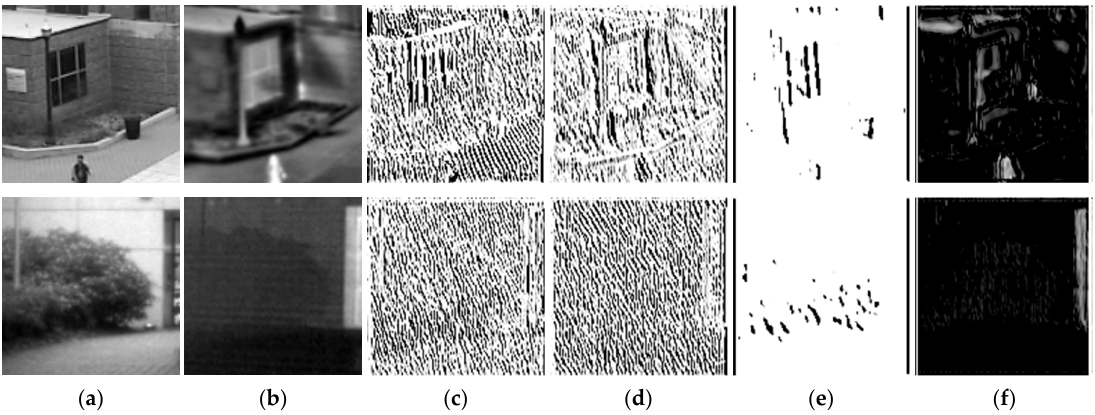
Figure 14. Comparison of fine-feature maps for shallow feature extraction network with and without shared weight. From left to right: ( a ) visible image patch, ( b ) infrared image patch, ( c ) visible fine-feature map in shared weight, ( d ) infrared fine-feature map in shared weight, ( e ) visible fine-feature map in w/o. shared weight (proposed method), and ( f ) infrared fine-feature map w/o. shared weight (proposed method). Table 4. Comparison of corner error [31] for shallow feature extraction network with and without weight sharing. Row 2 and 3 represent the corner error [31] corresponding to the two sets of sample images in Figure 14, respectively. Column 2 represents the corner error [31] resulting from shallow feature extraction network in shared weight. Column 3 represents the corner error [31] resulting from shallow feature extraction network w/o. shared weight.